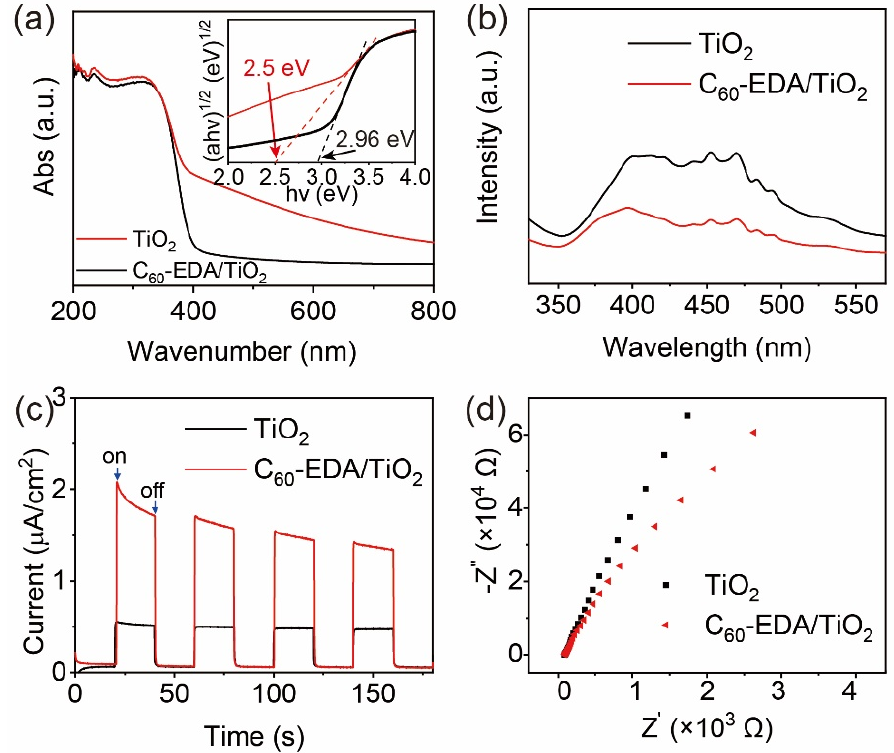
Figure 4. ( a ) UV diffuse reflectance spectra (inset is band gap energy diagram), ( b ) fluorescence spectra, ( c ) photocurrent response, and ( d ) AC impedance of TiO 2 and C 60 ‐ EDA/TiO 2 .